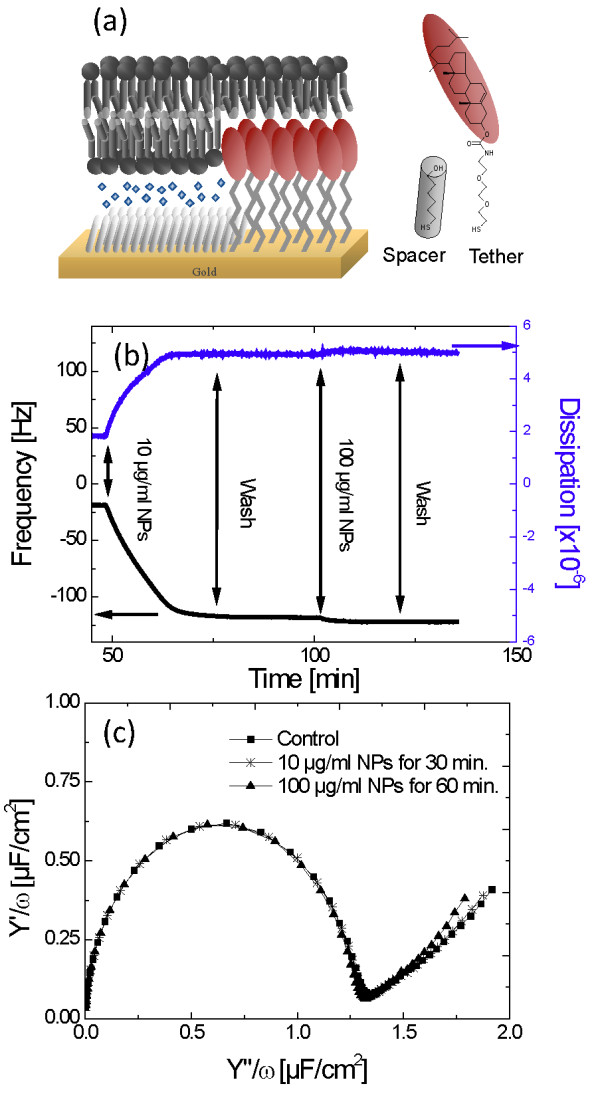
(a) Schematic of the tBLM system used in (b) and (c). A gold surface is modified with a mixed self-assembled monolayer containing cholesterol groups. The surface is then incubated with vesicles made up of Lipid Mix 1 (POPC:DOPS:cholesterol at 15:1:4 weight ratio), which assembles into a planar membrane across the gold surface, (b) QCM-D plots of a tBLM in DMEM after additions of 10 and 100 μg/ml of silica NPs (dispersed in DMEM) and after washes with DMEM at times indicated by the arrows. (c) Impedance spectra plots (normalised admittance) of a tBLM in DMEM before and after incubation with 10 and 100 μg/ml of silica NPs at 21°C for the indicated time.